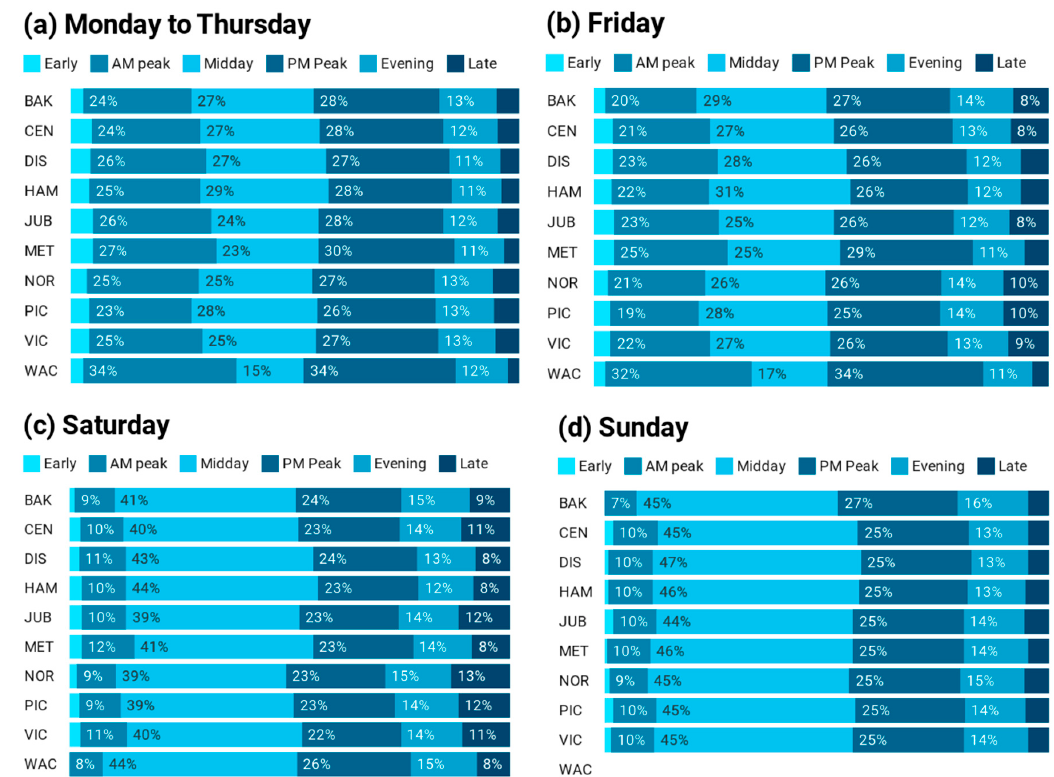
Figure 10. LU Daily passengers per Line.